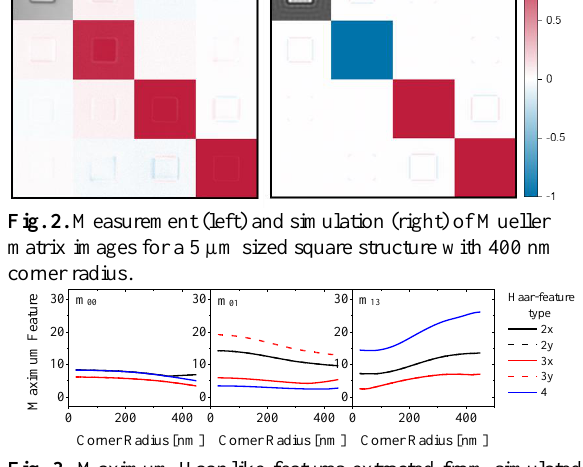
Fig. 3. Maximum Haar-like features extracted from simulated Mueller matrix images, depending on corner radius